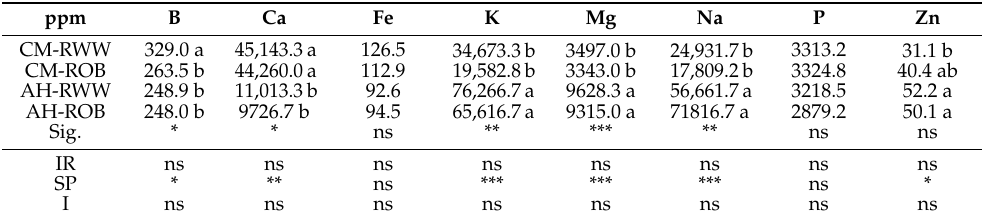
Table 5. Leaf mineral concentration in Crithmum maritimum (CM) and Atriplex halimus (AH), irrigated with reclaimed wastewater (RWW) and reverse osmosis brine (ROB). Results were from one-way and two-way ANOVA tests on these parameters for independent variables (irrigation, IR, and species, SP) and their interaction (I). Values are means of three samples.